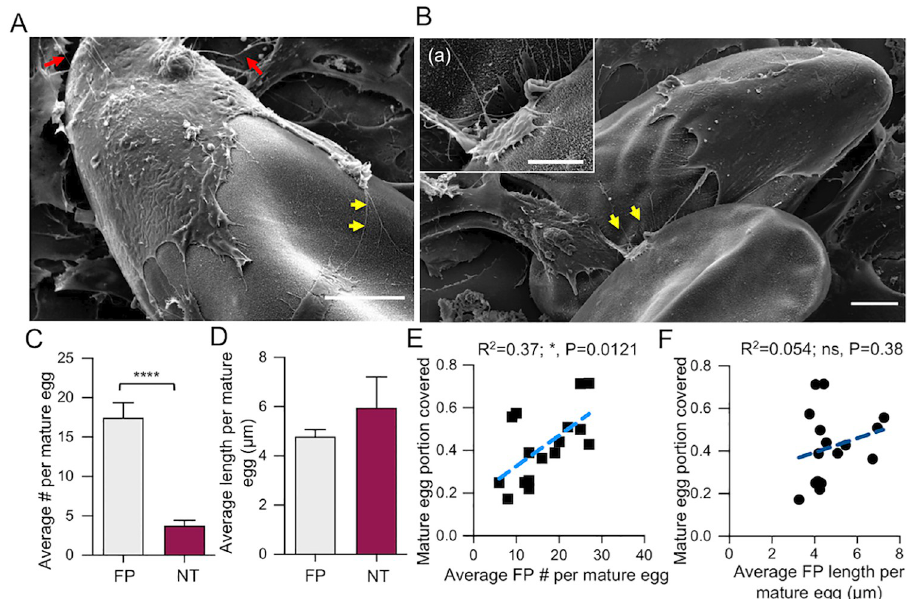
Fig 2. VECs interacting with S . mansoni eggs display two types of membrane protrusions. (A) During encapsulation, VECs extend filopodia (FP; yellow arrows), to probe the egg surface, and intercellular nanotubes (NTs; red arrows) to connect with neighboring cells (scale bar: 10 μ m). (B) Representative SEM image to illustrate how filopodial probing facilitates VEC migration over eggs: (a) enlarged image of the probing FP corresponding to the region indicated by the yellow arrowheads (scale bar: 4 μ m). (C) Average number of FPs and NTs formed per mature egg after 4 h. (D) Average length of FPs and NTs formed per mature egg after 4 h. Bar plots in C and D represent mean ± s.e.m. ���� indicate p < 0.0001 by Student’s t -test. (E) Egg portion covered by VECs as a function of average FP number. (F) Egg portion covered by VECs as a function of average FP length. For both E and F , � indicates statistically significant Pearson correlation (p = 0.0121). For C—F , a total of 16 mature eggs from three independent experiments were analyzed.